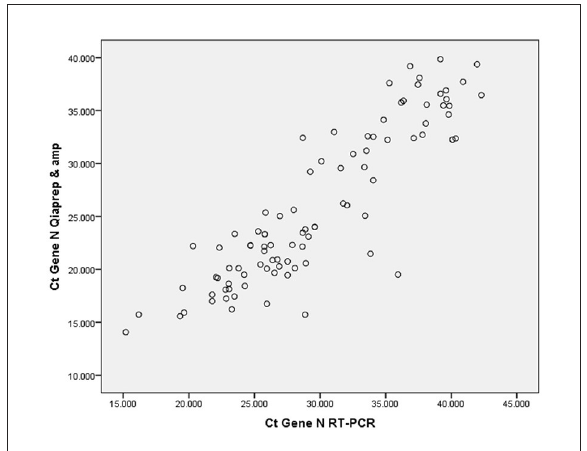
FIGURE1 Comparison between real time PCR with QIA P&A and manual PCR assay. The distribution of the Ct gene sample N (confirmatory test) shows a correlation coefficient (r) of 0.45.